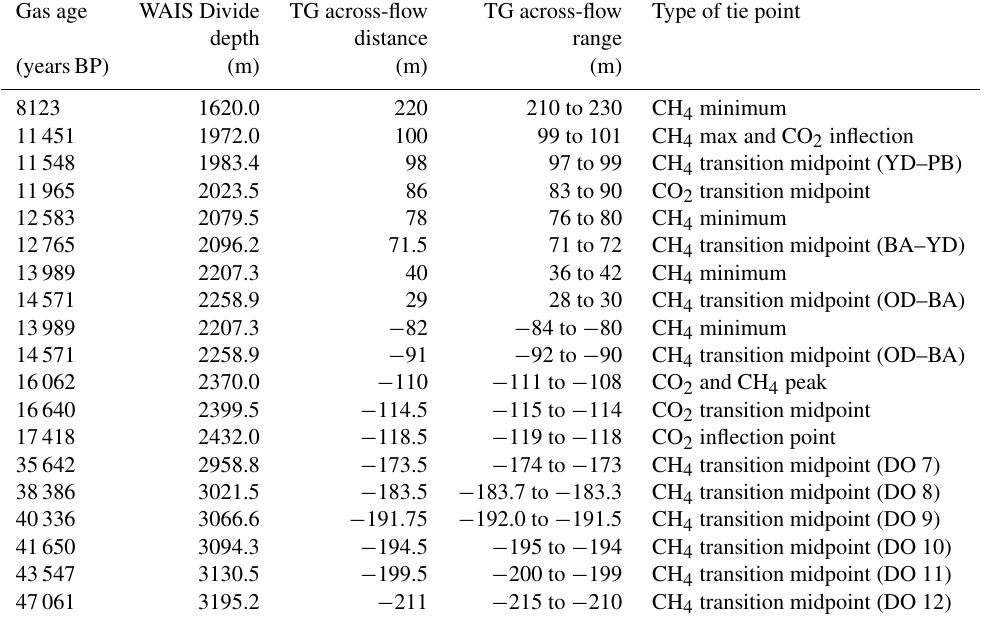
Table 1. Fixed tie points used in the gas age model synchronizing Taylor Glacier to WAIS Divide. Note that two tie points (at 2207.3 and 2258.9m WAIS Divide depth) are overlapping, i.e. are used both for the “old” and the “young” side of the transect. WAIS Divide is on the WD2014 age scale (Buizert et al.,